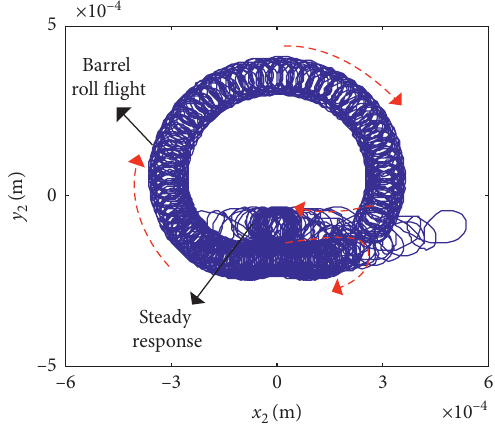
Figure 8: Transient axis orbit of the disk m